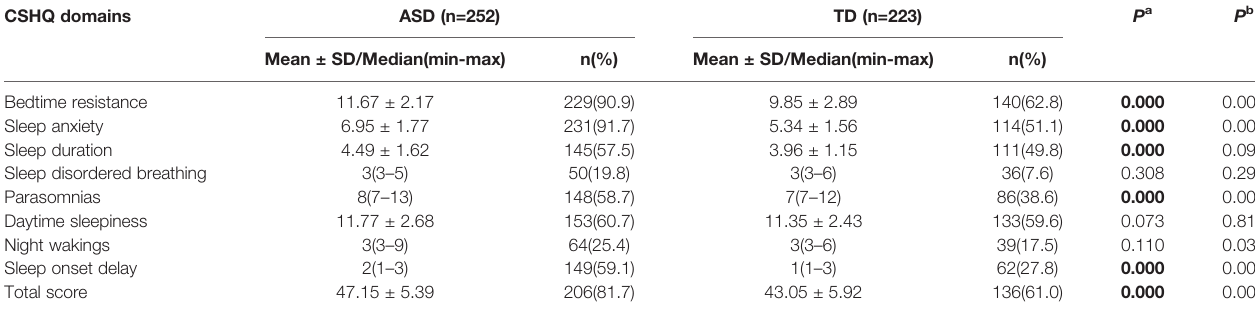
TABLE 2 | Sleep problems in the ASD group compared to the TD